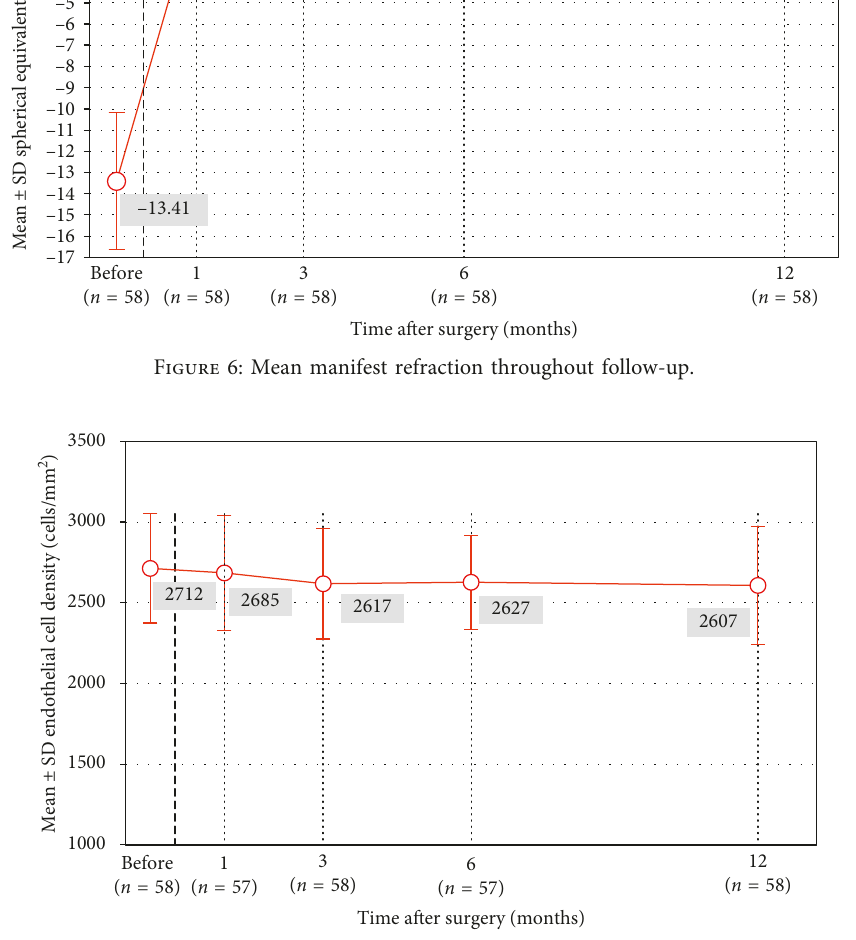
Figure 7: Mean endothelial cell count ( n � 58, repeated measures ANOVA, all visits, p < 0 . 001). Statistically significant difference was observed from preoperative visit to postoperative month 3 ( p � 0 . 001), postoperative month 6 ( p < 0 . 001), and postoperative month 12 ( p � 0 . 003). No statistically significant difference was observed from preoperative visit to postoperative month 1 ( p � 0 . 1267). ECD loss from three months to 12 months was not statistically significant ( p � 0 .